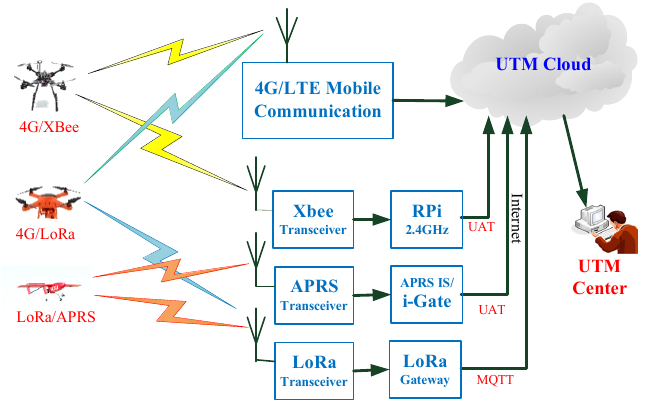
Figure 15. System redundancy using multiple ADS-B like system.